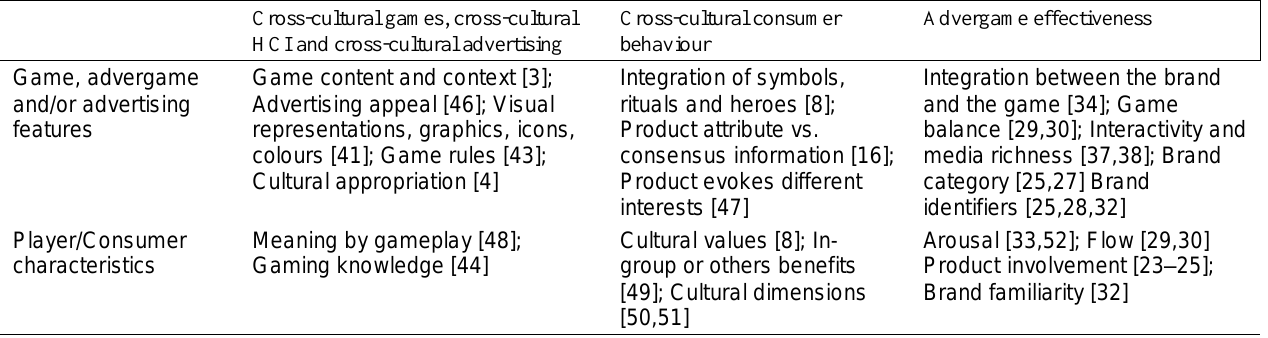
Table 3 Components of the two sides of the triad cross-cultural games and HCI, cross-cultural